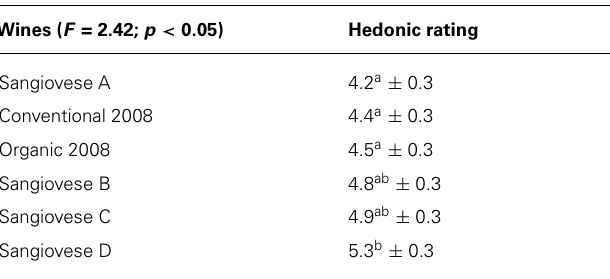
Table 2 | Mean hedonic ratings ( ± STDERR) for organic and conventional Romagna Sangiovese wines from vintage 2008 and other four commercial Romagna Sangiovese wines from conventional agricultural techniques (SangioveA–D). Wines ( F = 2.42; p <